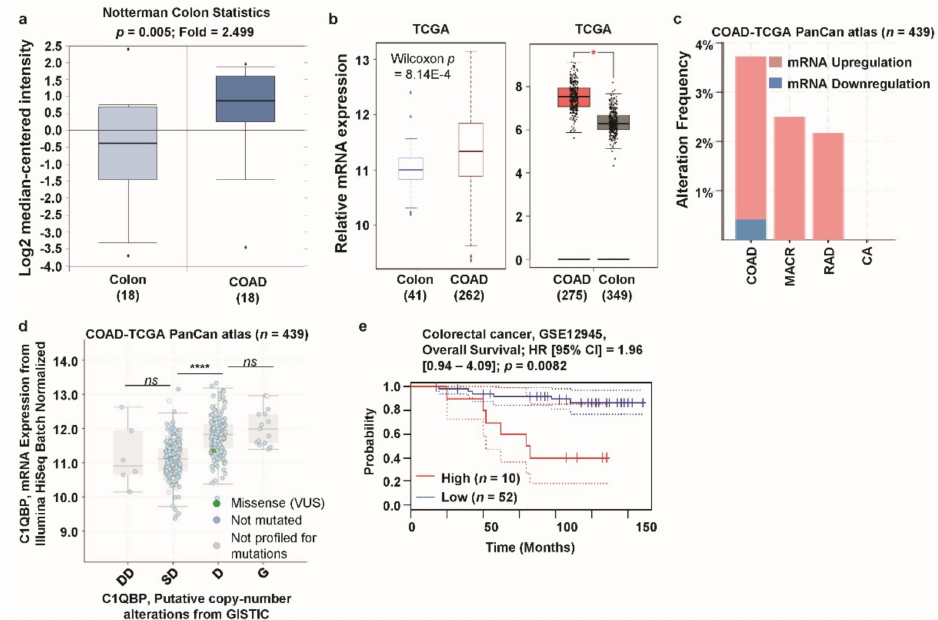
Figure 4. C1QBP expression pattern and patient survival analysis in colon cancer: comparison of C1QBP expression in normal tissue and cancer tissue. ( a ) The fold-change of C1QBP in colon cancers was identified by our analyses, represented as a box plot. The box plot comparing specific C1QBP expression in normal ( n = 18, left plot) and cancer tissue ( n = 18, right plot) was derived from the Oncomine database. The analysis was performed in COAD in comparison to normal colon. The asterisk above and below the box represent maximum and minimum value, respectively. ( b ) Expression of C1QBP gene in the Cancer Genome Atlas (TCGA) database. Box plots showing the C1QBP mRNA expression in COAD tumors (T, red plot) and the respective normal (N, gray / blue plot) tissues, using data from the TCGA database through TCGA Wanderer and Gene Expression Profiling Interactive Analysis (GEPIA). *: p < 0.01. ( c ) Alterations (mRNA upregulation / downregulation) of the C1QBP gene in COAD (TCGA PanCanAtlas; n = 439). Data was obtained using cBioPortal. ( d ) C1QBP mRNA expression was significantly associated with the copy number alteration status (ANOVA, p < 0.0001) in colon cancer. (****: p < 0.0001; ns : nonsignificant). ( e ) The survival curve comparing patients with high (red) and low (blue) expression in colon cancer was plotted from the PrognoScan database. Survival curve analysis was conducted using a threshold Cox p -value < 0.05. Abbreviations. COAD: colon adenocarcinoma; MACR: mucinous adenocarcinoma of the colon and rectum; RAD: rectal adenocarcinoma; CA: colorectal